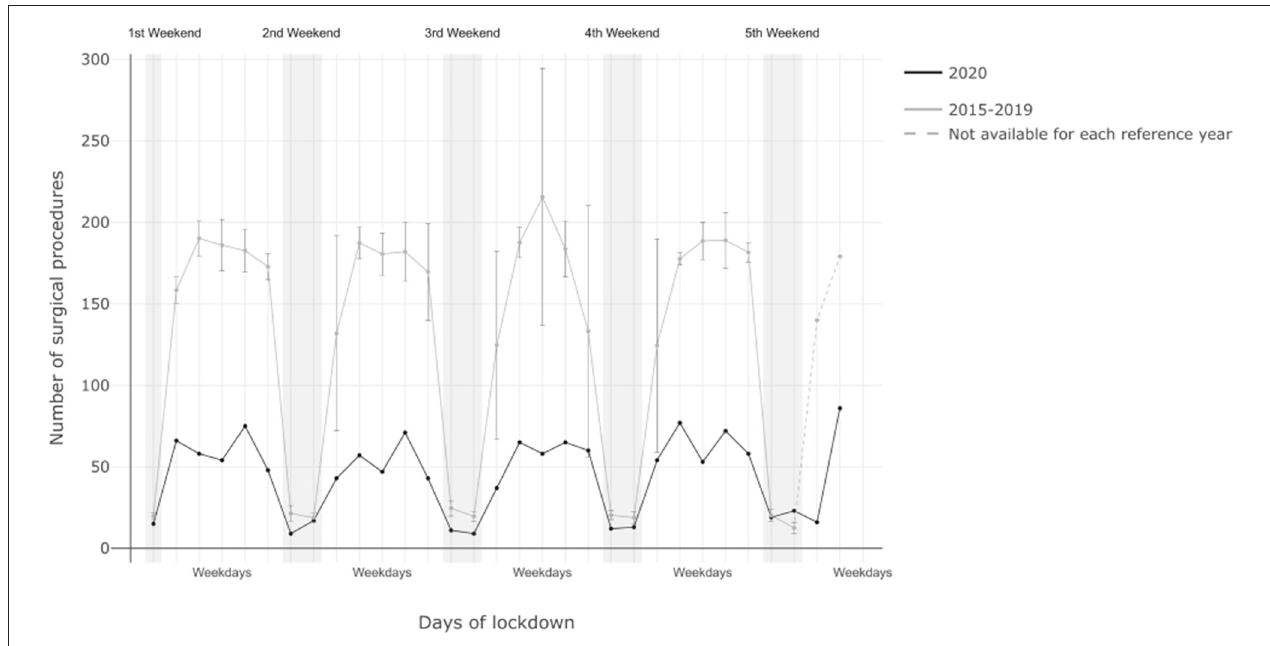
FIGURE 1 | Shown is the timing of surgical procedures performed in the observation period in 2020 compared to the same period in